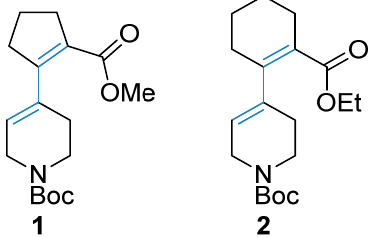
Figure 2. Formulae of conjugated dienes considered in this